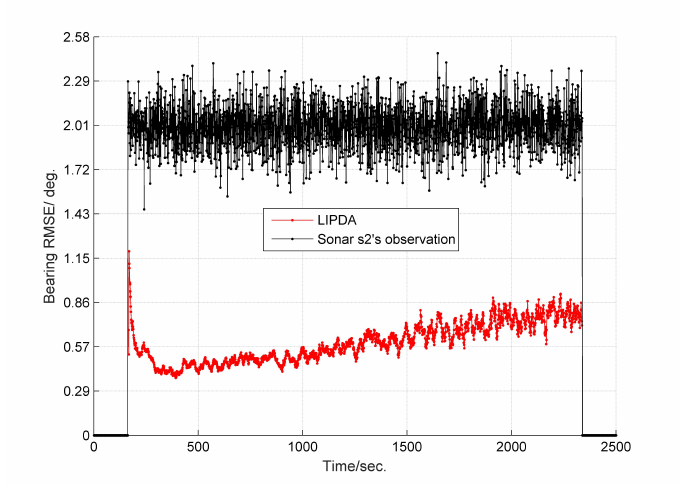
Figure 4. RMSE of estimated target bearing and the raw bearing observed by sonar s 2 at case 1.